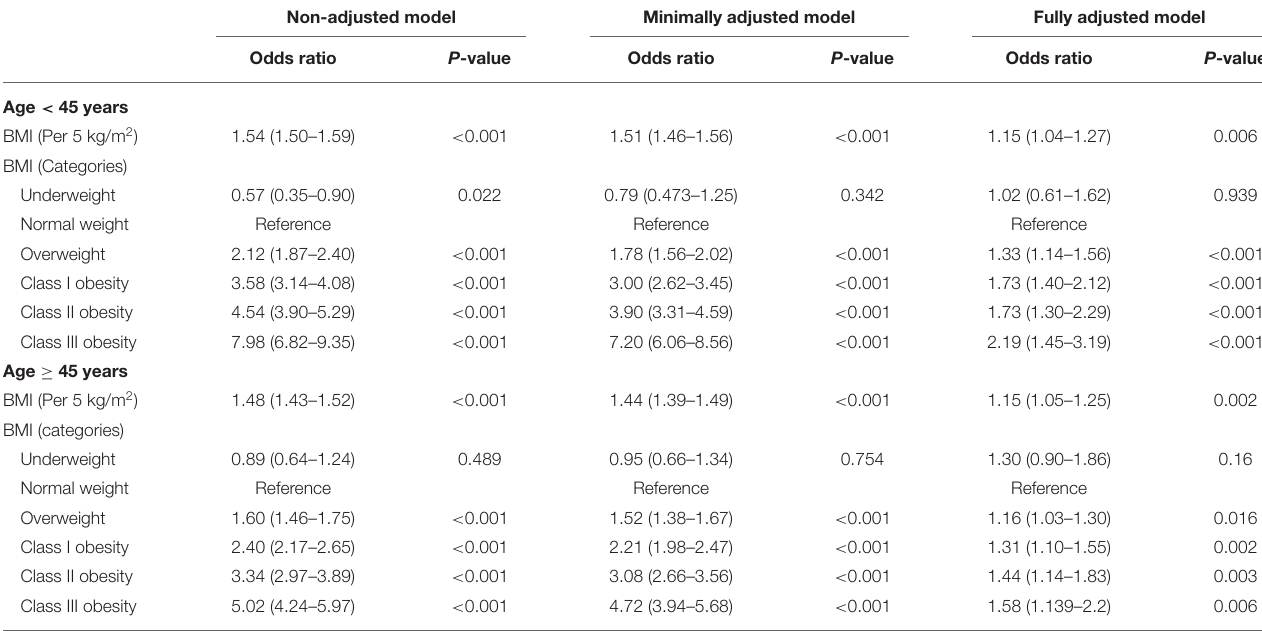
TABLE 2 | The association between body mass index and (pre) hypertension.